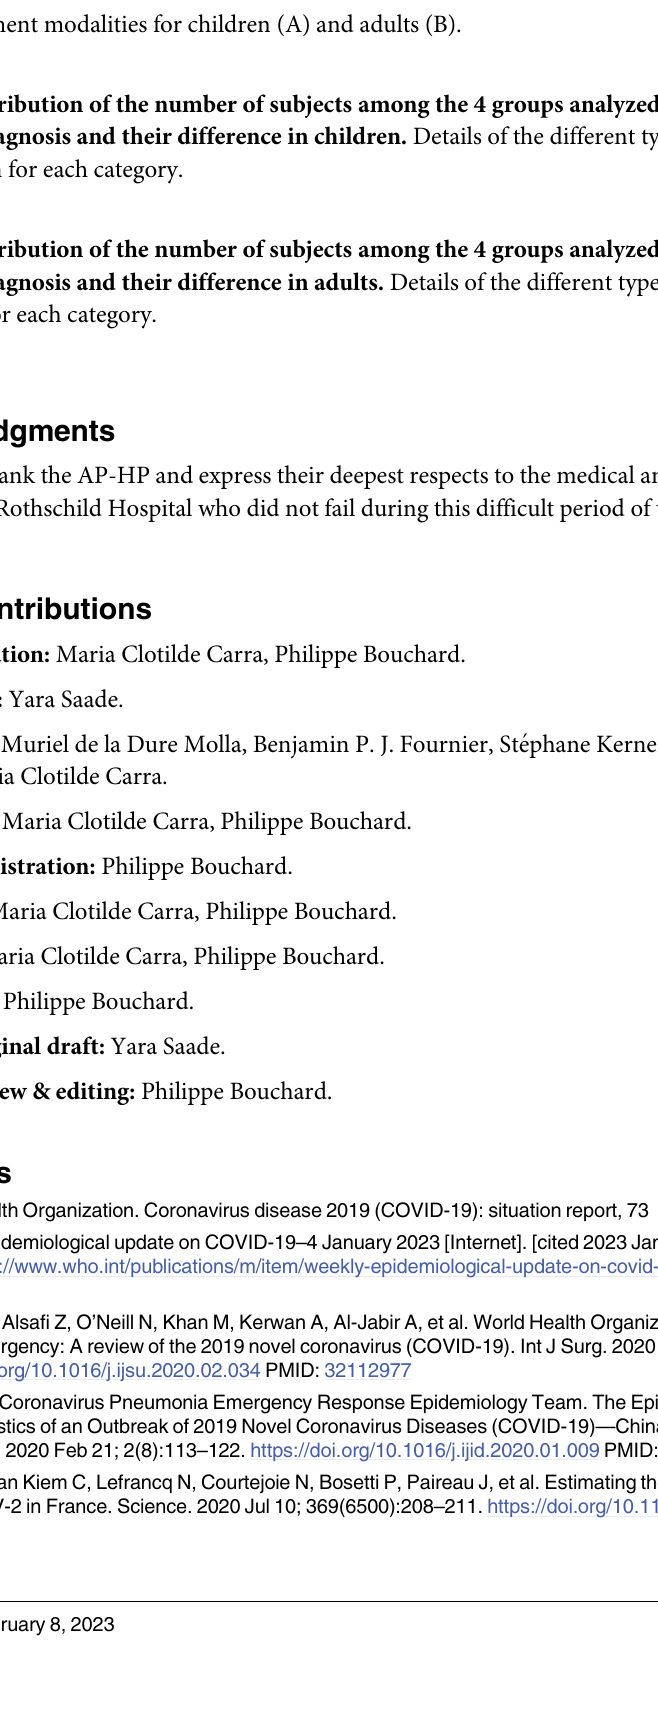
S3 Fig. Weekly patients’ hospital visits during the lockdown period. (TIF) S4 Fig. Treatment modalities for children (A) and adults (B). (TIF) S1 Table. Distribution of the number of subjects among the 4 groups analyzed according to triage or diagnosis and their difference in children. Details of the different types of diag- noses are given for each category. (PDF) S2 Table. Distribution of the number of subjects among the 4 groups analyzed according to triage or diagnosis and their difference in adults. Details of the different types of diagno- ses are given for each